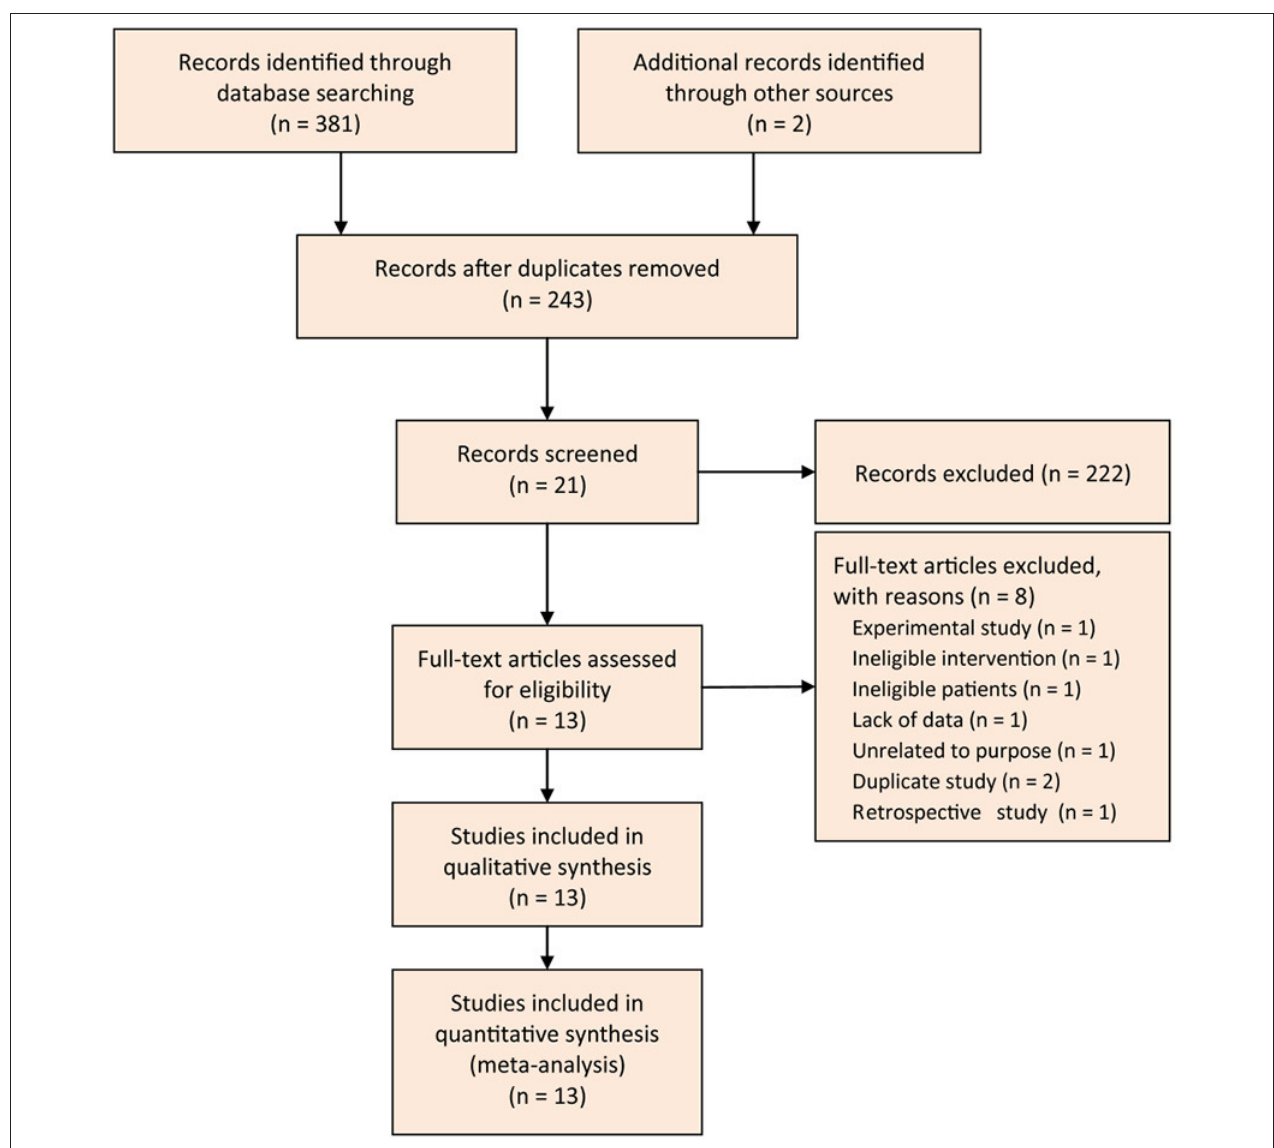
FIGURE 1 | Flow diagram of retrieval and screen of